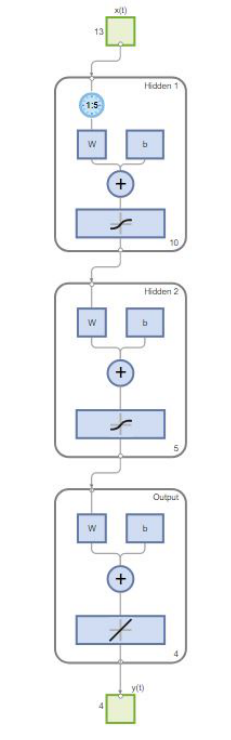
Figure 7. Architecture of final 13-input artificial neural network.